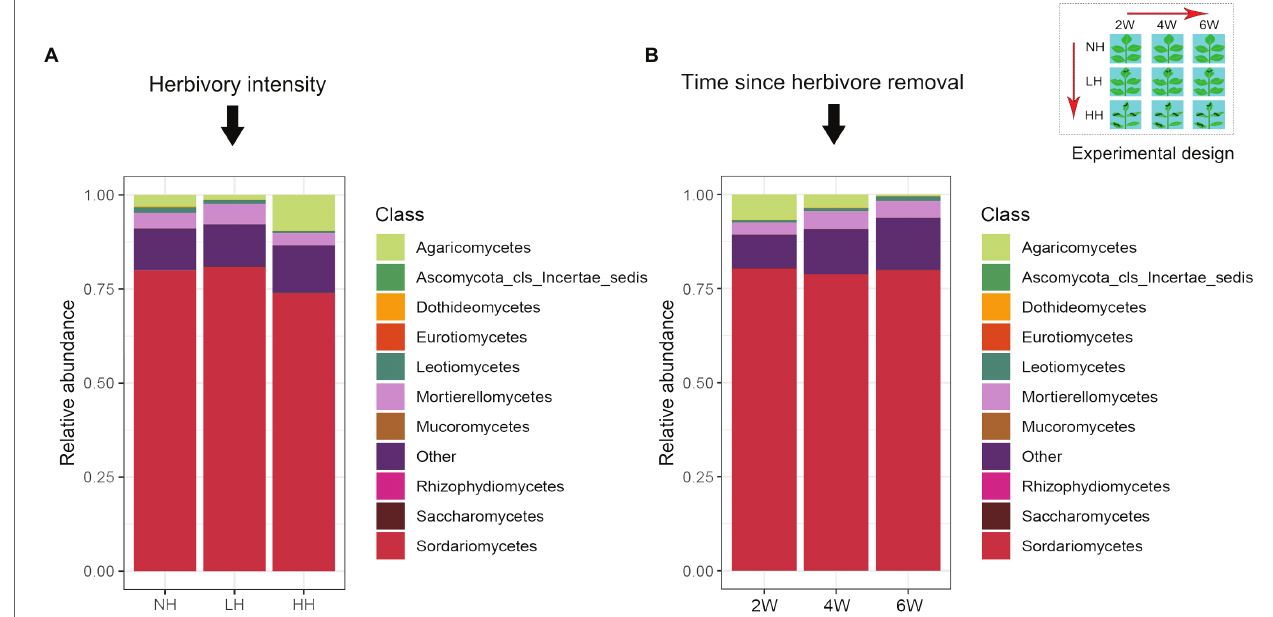
FIGURE 1 | Relative abundance of the dominant fungal classes in rhizosphere soils as affected by different herbivory intensities (A) and time since herbivore removal (B) .